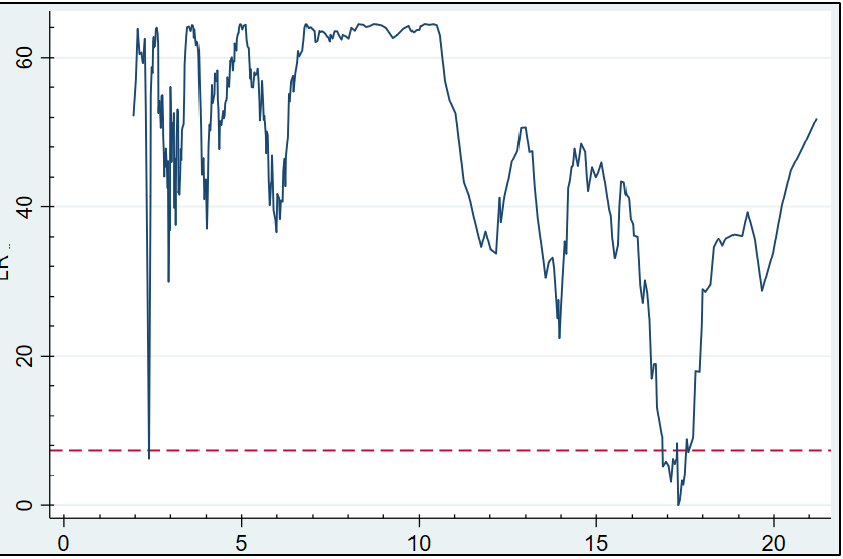
Figure 1. Double threshold estimate. Note: The vertical axis represents the Likelihood Ratio Sequence; the horizontal axis represents the Threshold Variable; the solid blue line represents the LR function; the red dashed line represents the 95% Critical.